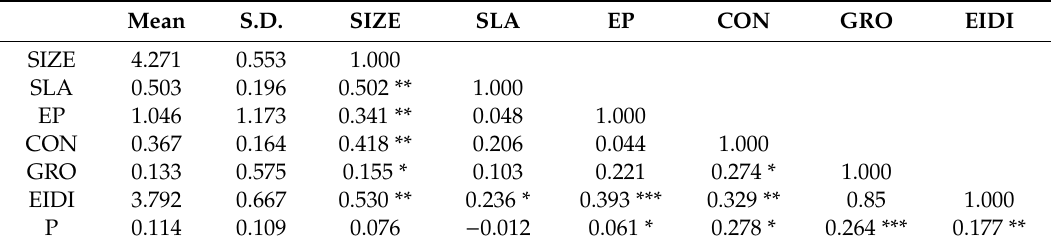
Table 2. Descriptive statistics of symbolic-style